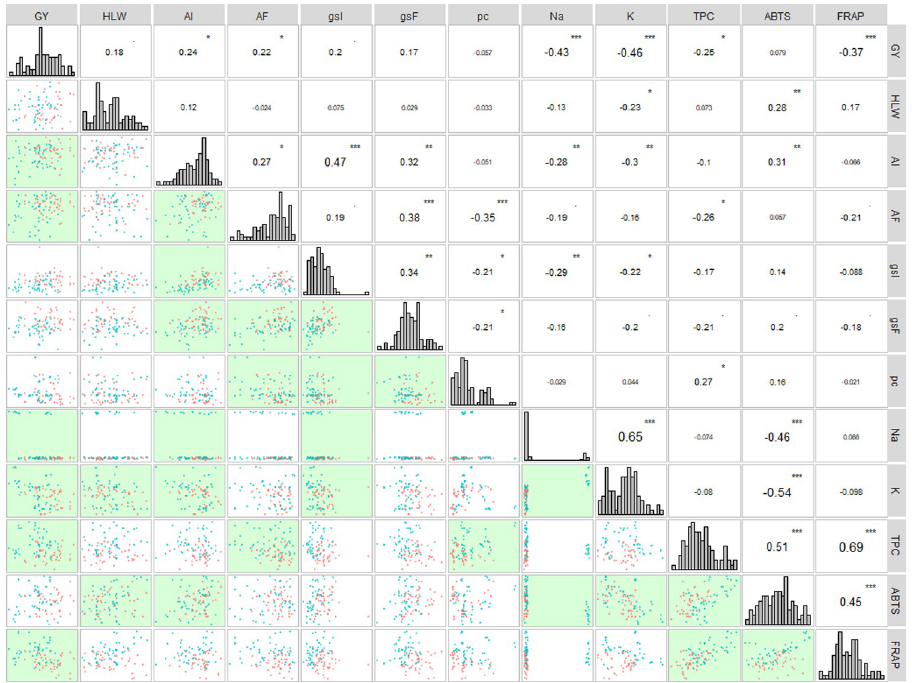
Fig 4. Pearson’s linear correlation between the ten studied traits. The lower diagonal shows the scatter plot where the environments are mapped with different point colors (Control = cyan and Drought = salmon). Grain yield (GY), hectolitre weight (HLW), initial liquid photosynthesis (AI) and final liquid photosynthesis (AF), initial stomatal conductance (gsI) and final stomatal conductance (gsF), proline content (pc), sodium (Na) and potassium (K), total phenolic compounds (TPC) and antioxidant activity by ABTS and FRAP